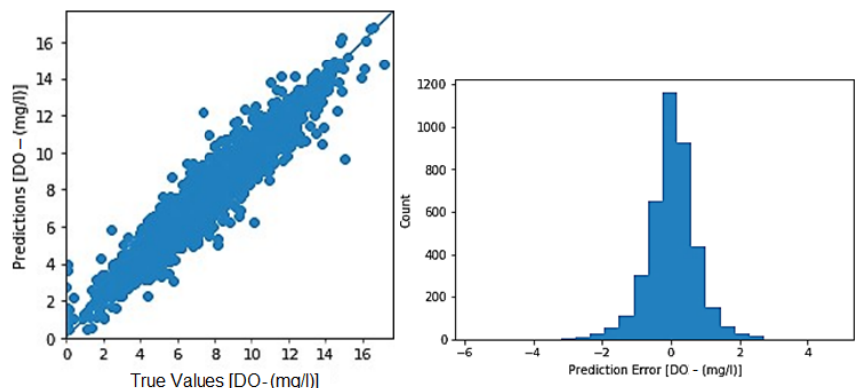
Figure 5. True vs. predicted values (left); predicted error (right) (Toichio station, structure 7-64-64- 1).